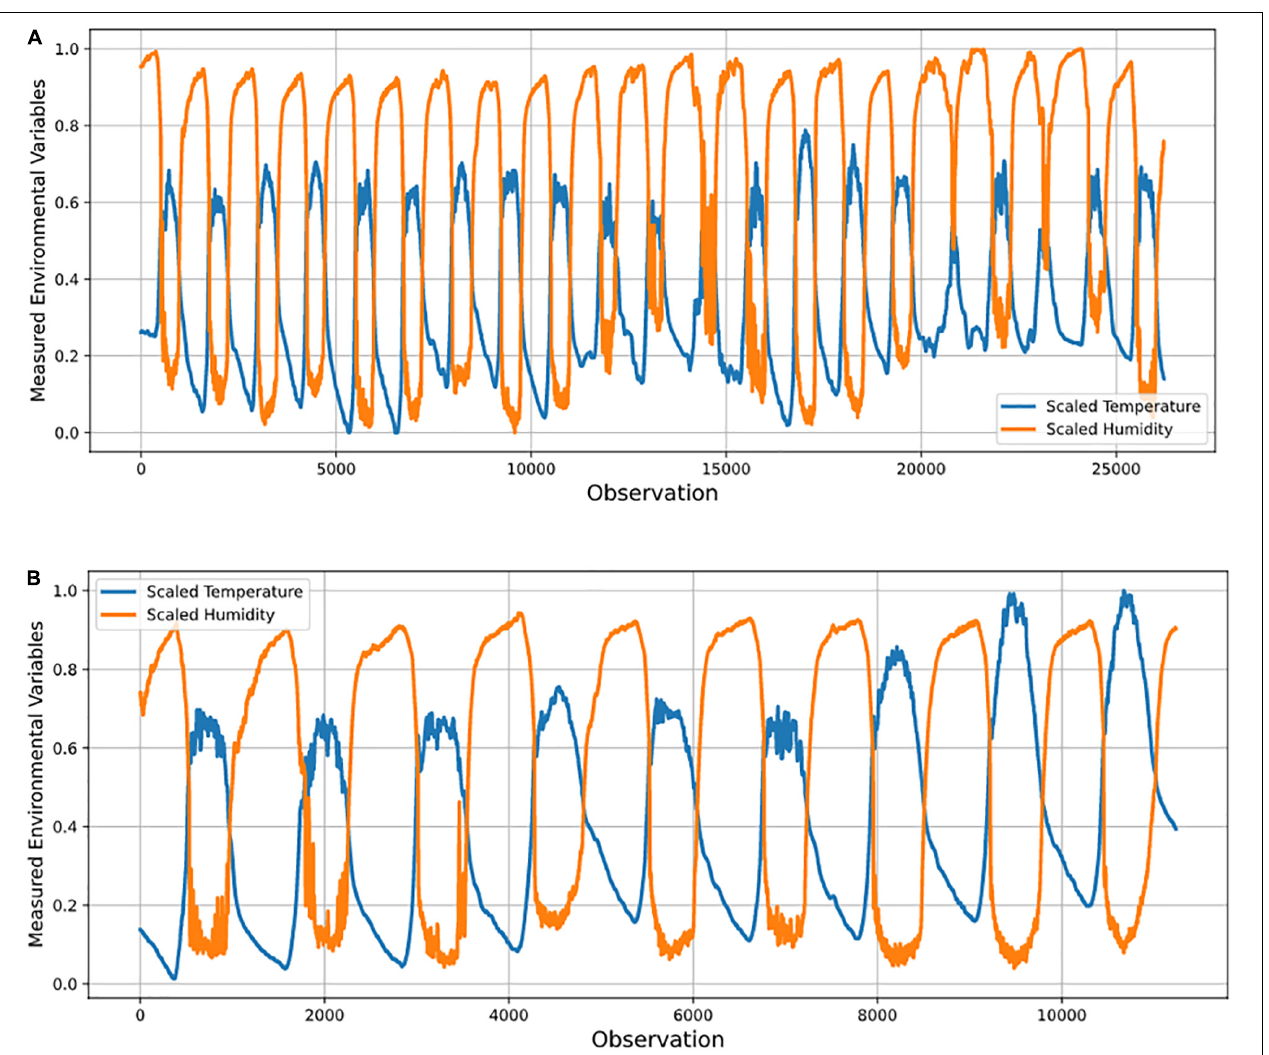
FIGURE 5 | Graphs of (A) training data; and (B) test data used in data preprocessing for sensor A1 in optimal sensor placement